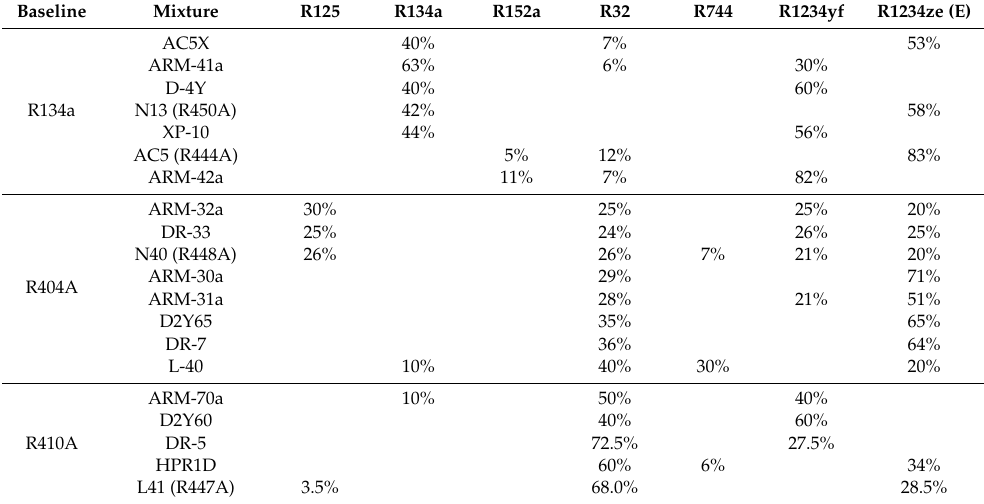
Table 3. HFC / HFO Mixtures composition by mass percentage [43]. Reproduced with permission from [Elsevier], Elsevier,